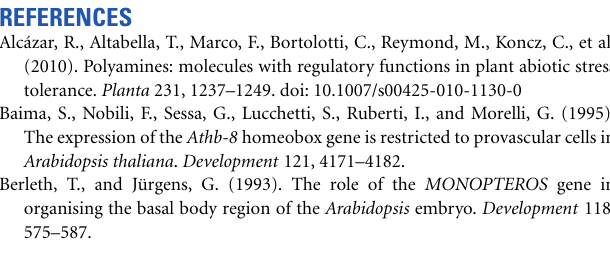
Supplemental Table 1 | List of the genes up-regulated in acl5-1 seedlings. Supplemental Table 2 | GO analysis of the gene up-regulated in acl5-1 seedlings. Supplemental Table 3 | List of the genes down-regulated in acl5-1